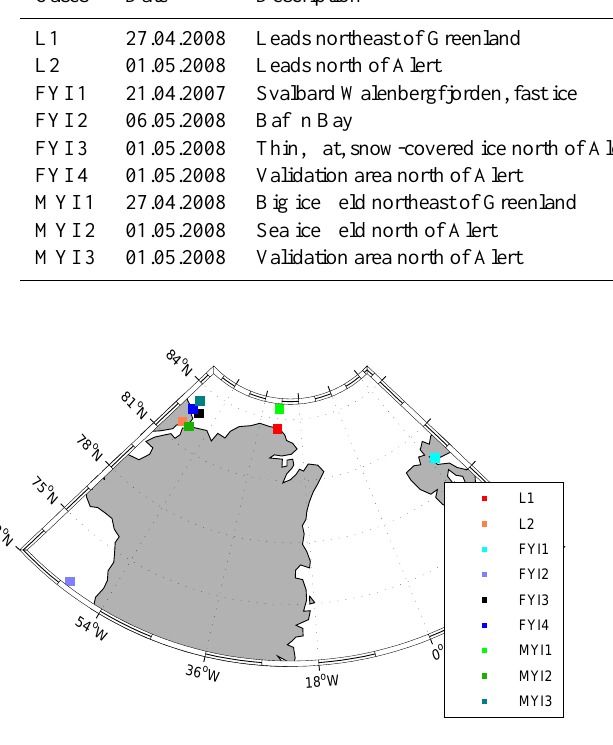
Fig. 1: Map showing the approximate location for each of the evaluated cases (see detailed descrip- Fig. 1. Map showing the approximate location for each of the evalu- tion in table 1). Cases with leads (L) are marked in red colors, first year ice (FYI) in blue and multi ated cases (see detailed description in Table 1). Cases with leads (L) year ice (MYI) in green. are marked in red colors, first-year ice (FYI) in blue and multi-year ice (MYI) in green.